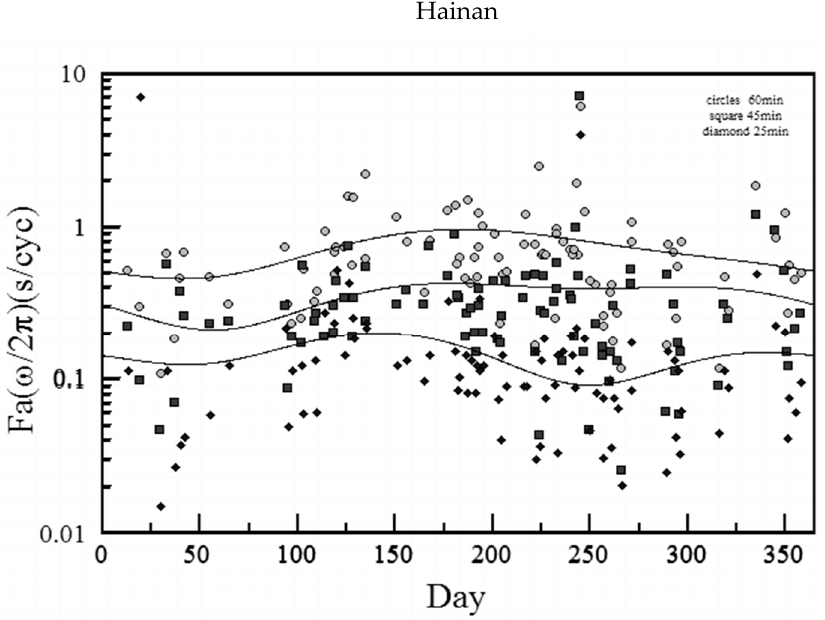
Figure 3. Distribution of variations of F a ( ω ) statistical seasonally and their MMSE fit at 2 π /60 min, 2 π /40 min, and 2 π /25 min. in Beijing ( top ), Hefei ( middle ), and Hainan ( bottom ).